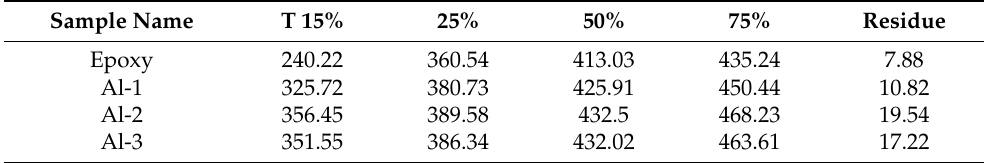
Table 2. Temperatures at various percentages of weight loss.